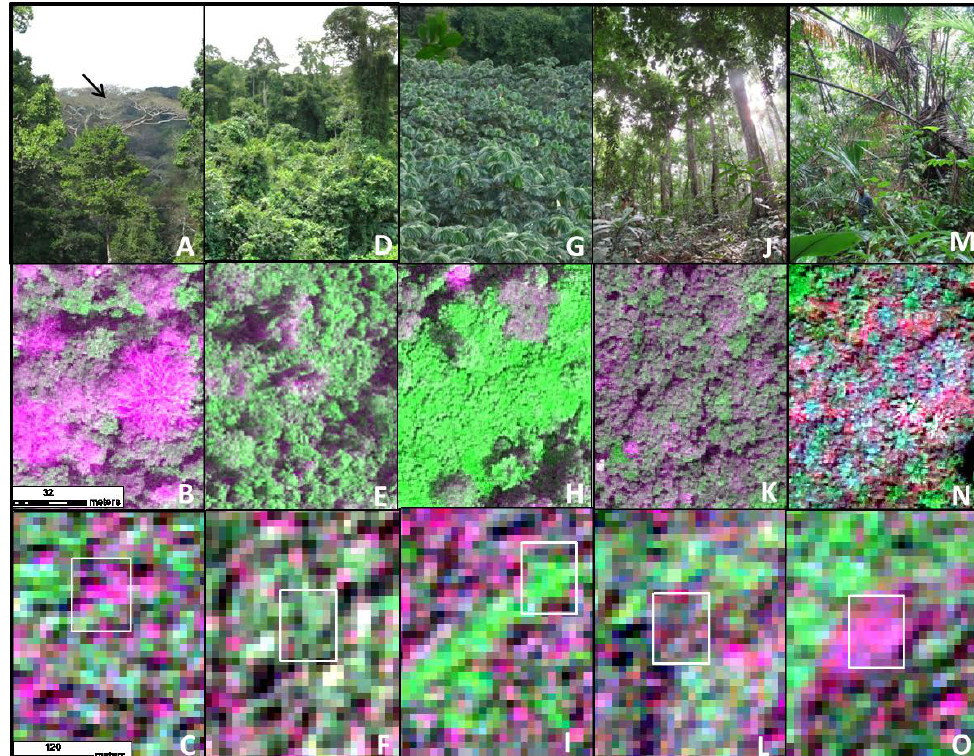
Fig. 1. Characteristics and criteria for visual discrimination of the main forest types on ground photographs, Red/Near Infrared/Green very-high-spatial-resolution GeoEye and high-spatial-resolution SPOT-5 composites acquired in Dry Season. A-D-G-J-M: Ground level or canopy level pictures. B-E-H-K-N: Extracts from a very-high-spatial-resolution GeoEye image (0.5m pixels). C-F-I-L-O: Extracts from a high-spatial-resolution SPOT-5 image (10m pixels). Footprint of the corresponding GeoEye image appears in the form of white rectangle. A-B-C: Mixed forests (MF 1–4). The arrow indicates a leafless tree (A) . On the GeoEye image (B) , deciduous trees show pinkish bare crowns and branches. On the SPOT image, deciduous trees appear as patches of a few pink pixels (C) ; D-E-F: Open Marantaceae forests; G-H-I: Young Secondary Forest; J-K-L: Monodominant Gilbertiodendron dewevrei forests; M-N-O: Swamp Forest with dominance of Raphia .